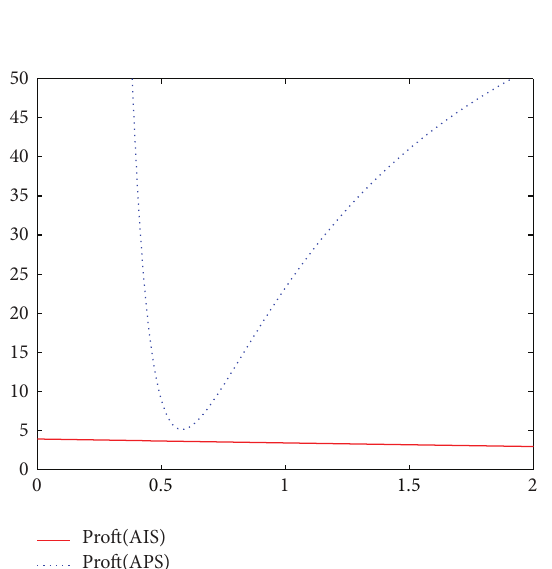
Figure 7: Total production.